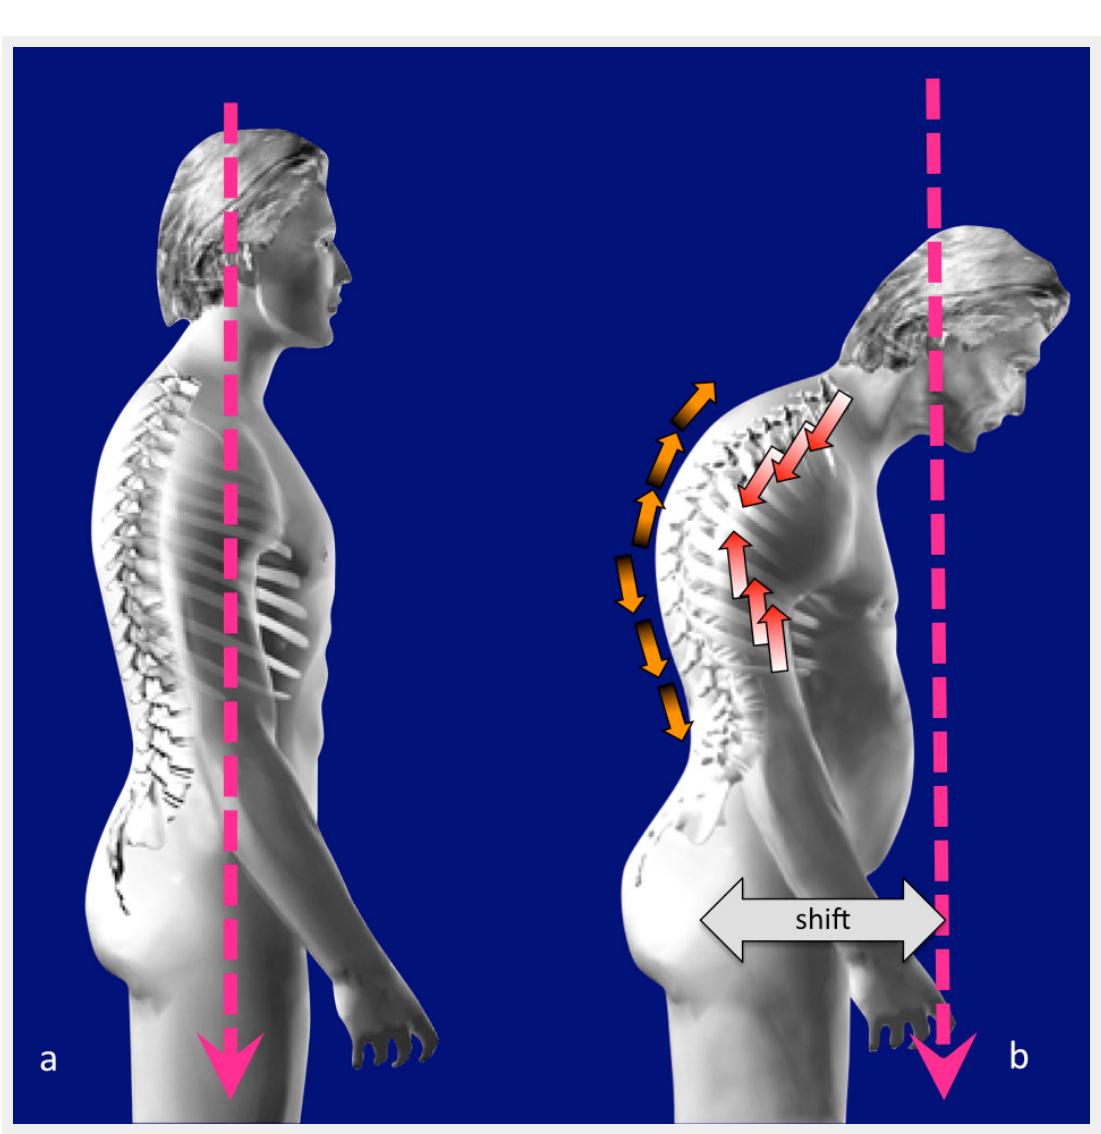
Figure 1 Loss of posture due to vertebral factures: The centre of gravity (pink) is in line with the hip joint in a balanced spine (a). Due to vertebral fractures increased kyphosis occurs and the centre of gravity is shifting forward, throwing the spine out of balance (b). This leads to higher compression loads on the vertebrae (red arrows) and higher strain on the back muscles (orange